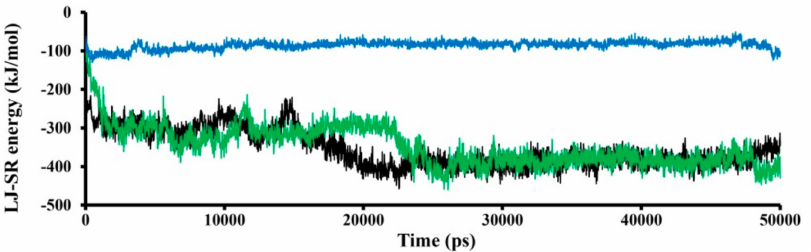
Figure 5. The Lennard–Jones short range (LJ-SR) binding energy between the TRPC4 channel and SWCNTs: SWCNT_1 model is shown in black, SWCNT_2 model in green and SWCNT_3 model in